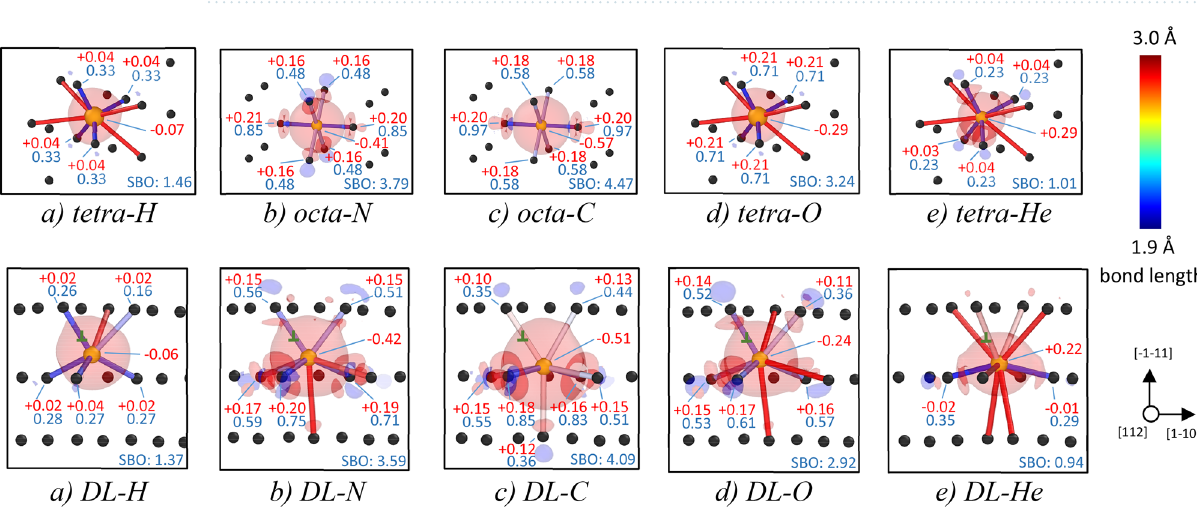
Figure 4. Charge density difference maps for impurities in the lowest energy position in bulk W (tetrahedral or octahedral positions) and around a dislocation loop of 37 SIAs. The view for the latter is shown in Fig. 1c. The colour of the bond corresponds to its length and is explained in the legend on the right hand side. Black circles are W atoms around the impurity, while yellow enlarged atoms are the corresponding impurities (ordered according to the their interaction energy with the loop from the lowest to the highest). The numbers in red are the corresponding net atomic charges, while the numbers in blue reveal the magnitude of bond order for the bond between the impurity and the relevant atom. The isosurfaces with the charge density difference of + 4.3 * 10 –7 e/A 3 (local increase of charge density) and − 4.3 * 10 –7 e/A 3 (local decrease of charge density) are visualized with red and blue colors, respectively. The images are created with OVITO [‘https:// www. ovito. org/’ version 3.0.0-dev] 27